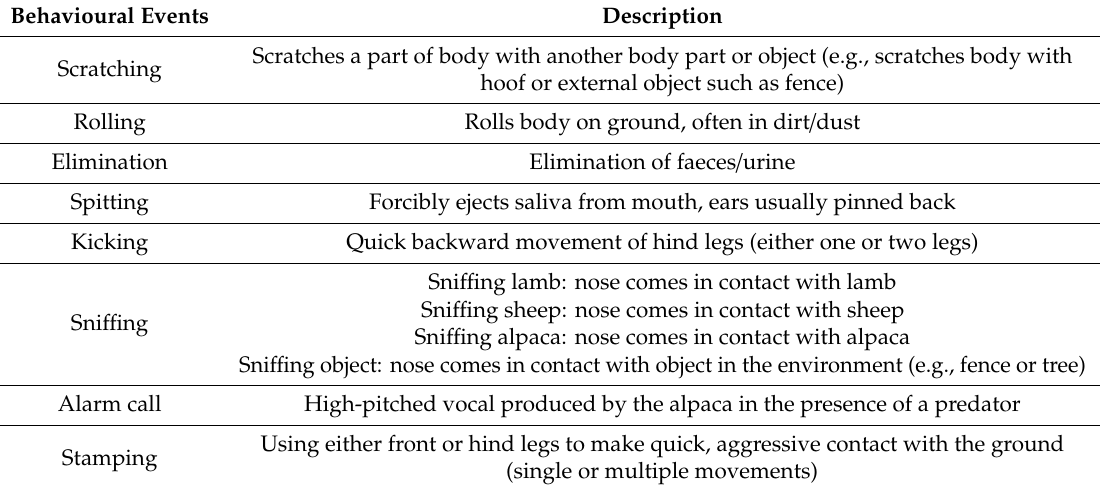
Table 2. Behavioural repertoire of alpacas: behavioural events (used to analyse video footage of alpaca field